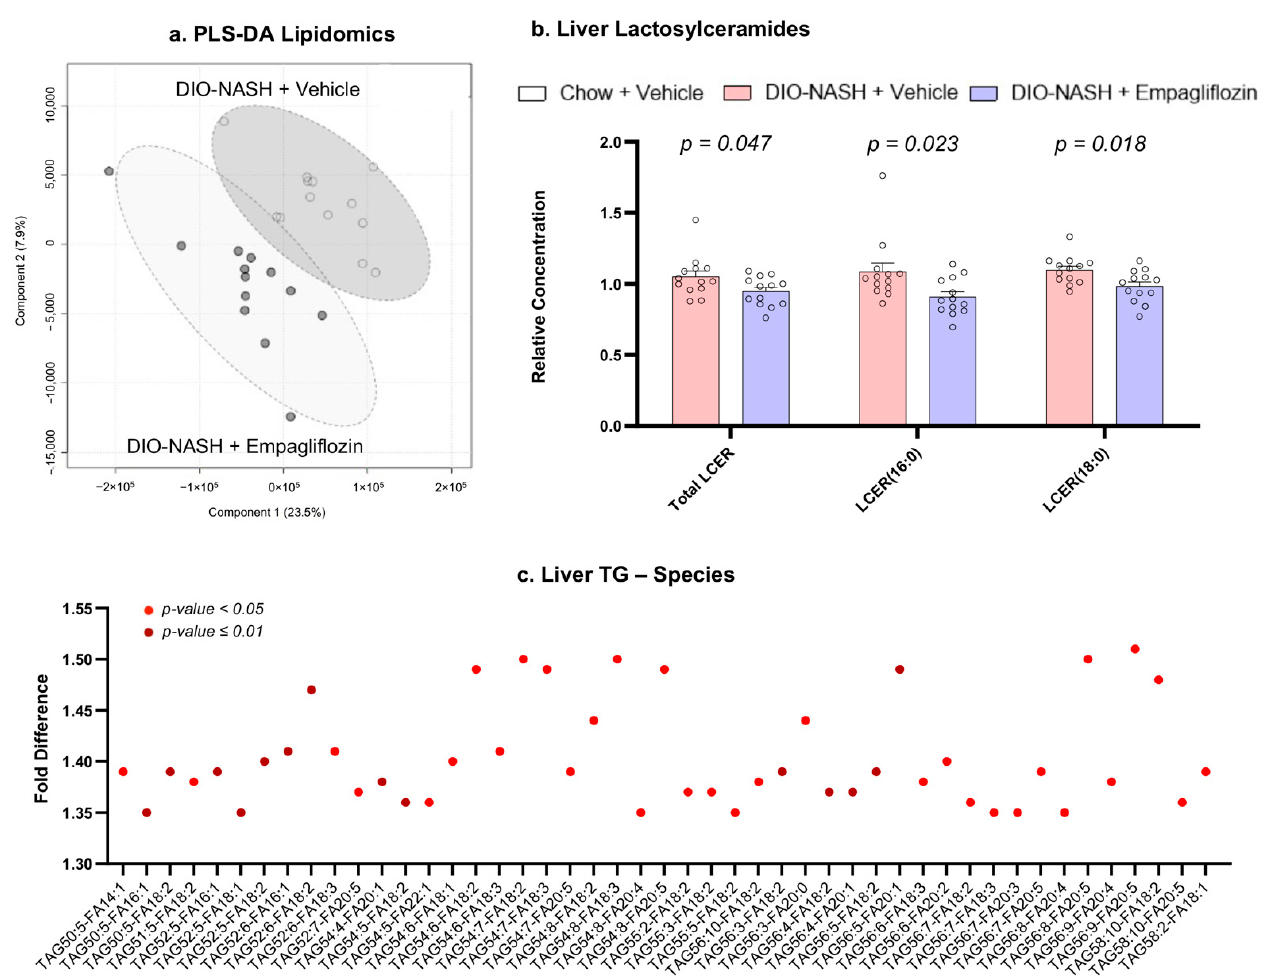
Figure 5. Empagliflozin affects hepatic lipidomes. ( a ) Score plot of the partial least squares ‐ discriminant analysis (PLS ‐ DA) showing the formation of two distinct clusters based on the treatment. Each black dot corresponds with a mouse treated with empagliflozin and each white dot with a mouse treated with the vehicle. The circles correspond with a 95% confidence interval for each group. ( b ) Relative concentrations of lactosylceramides in the liver in DIO ‐ NASH mice treated with the vehicle and empagliflozin. ( c ) Fold difference of the concentrations of triglyceride species in DIO ‐ NASH mice treated with empagliflozin compared with the vehicle. Triglyceride species with a fold difference > 1.3 are demonstrated (light red for p in t ‐ test < 0.05 and dark red for p < 0.01). In triglyceride species, red dots correspond with p < 0.05 and dark red dots with p ≤ 0.01. n = 13 for DIO ‐ NASH + vehicle and DIO ‐ NASH + empagliflozin.